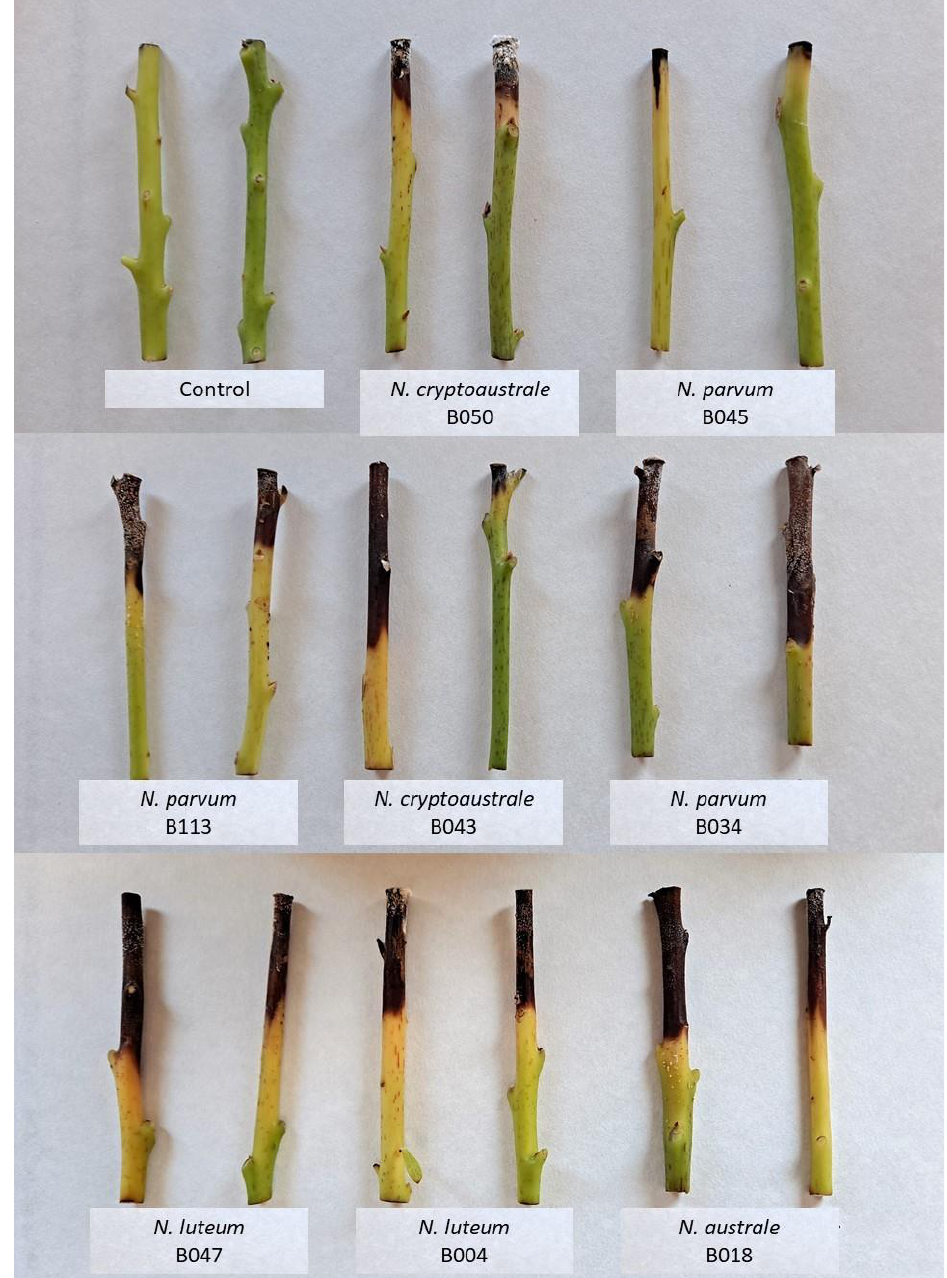
Figure 7. External symptoms in West Indian avocado seedlings 21 days after inoculation. Plants were pruned at the top, and they were inoculated by placing a mycelial plug onto the pruning-cut wound. Isolates B043, B050: N. cryptoaustrale / stellenboschiana . Negative control consists of plants inoculated with a fungus-free agar fragment.